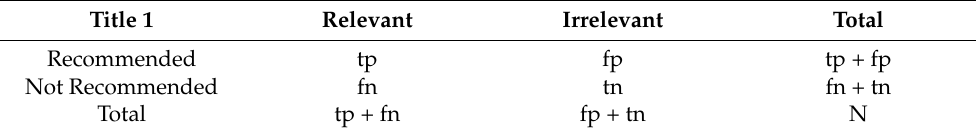
Table 1. The elements of confusion matrix.